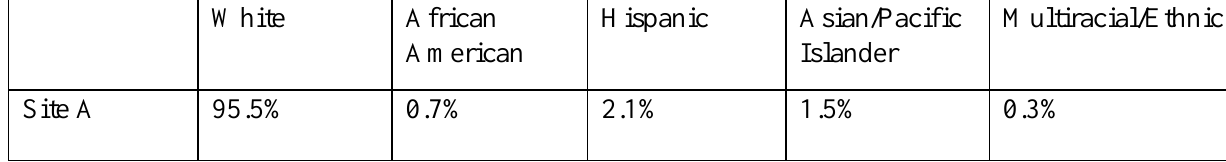
Cultural Group Percentages and Number of Students for the High School